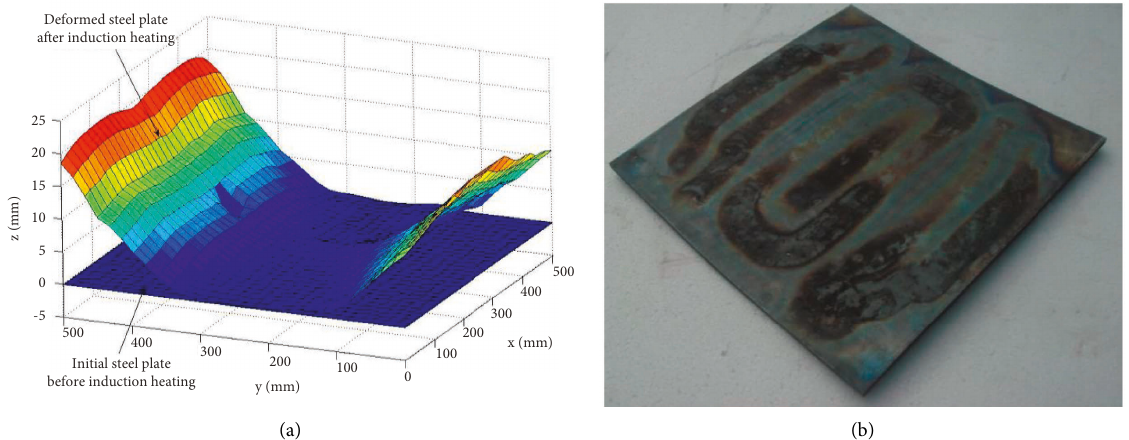
Figure 12: Measurement results: (a) target curvature transformation with the symmetric steel plate and (b) experiment on the real sample.